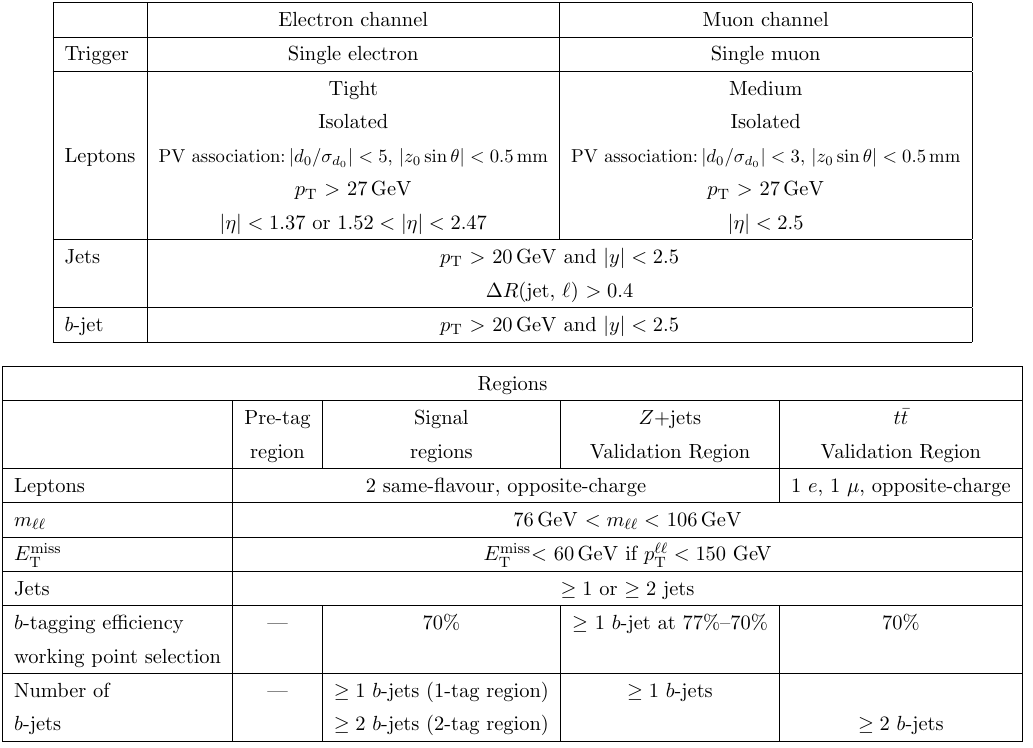
Table 3 . Summary of object and event selections de(cid:12)ning the signal regions and the validation regions for the main backgrounds of the analysis at detector